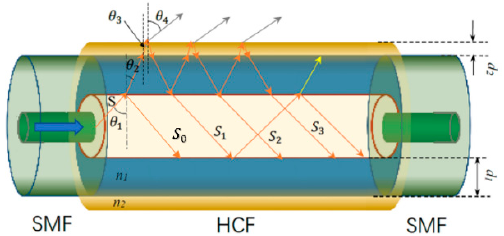
Figure 1. A schematic diagram of the coated single mode–hollow core–single mode (SMF–HCF–SMF) fiber structure.